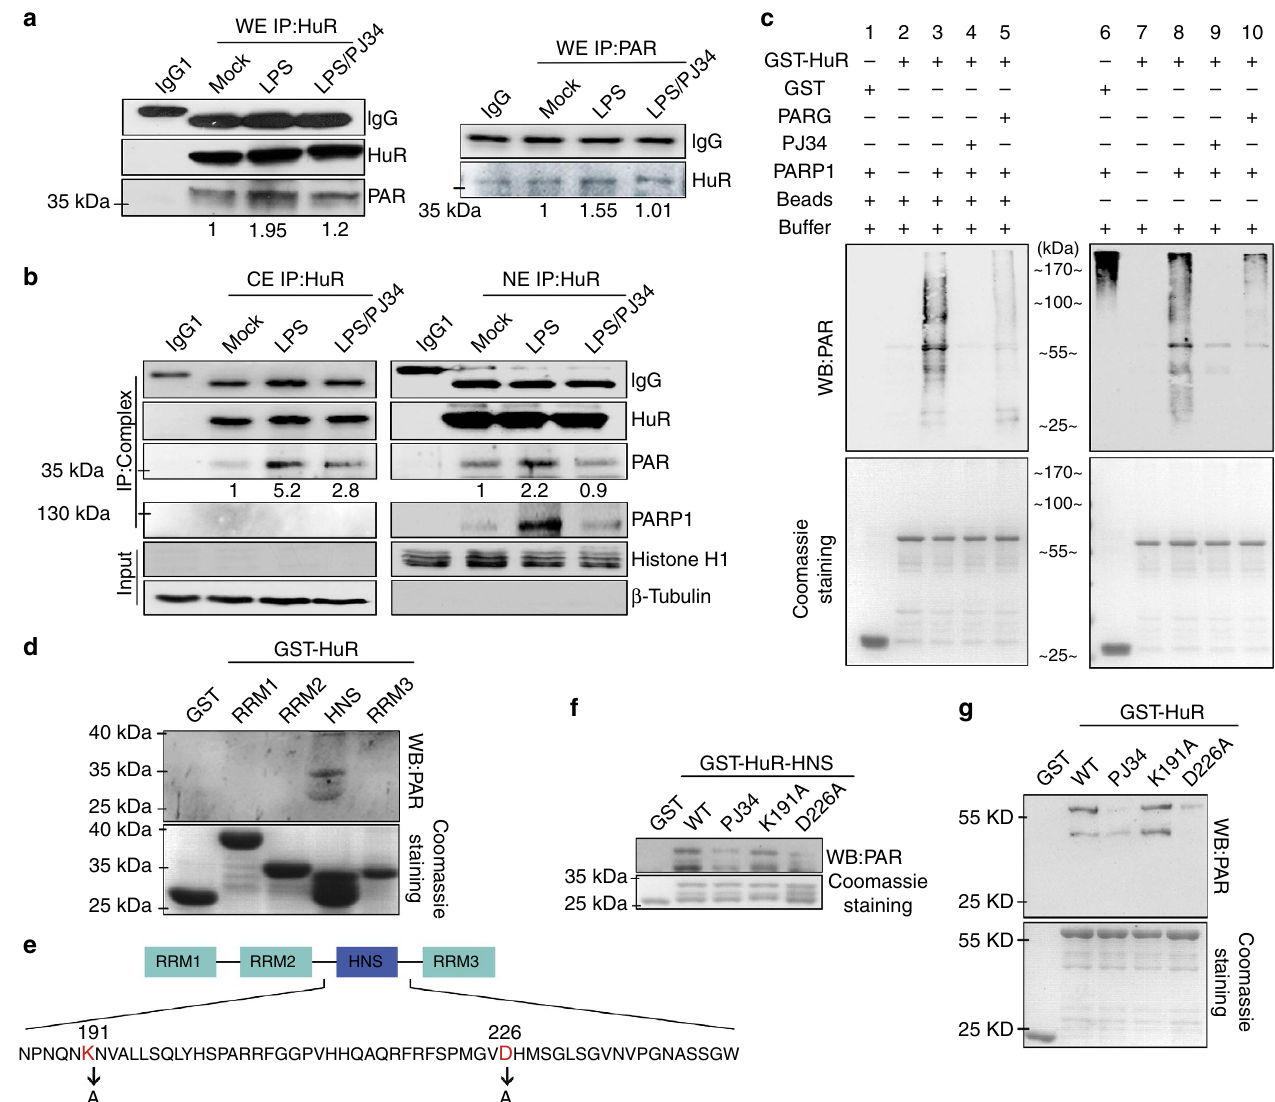
Figure 3 | PARP1 PARylates HuR primarily at aspartic acid 226 upon LPS stimulation. ( a ) LPS exposure increases the PARylation level of HuR. RAW 264.7 cells were mock-treated or LPS-exposed ( ± PJ34) for 5h. Immuno-precipitates were prepared using antibodies recognizing HuR (left) or PAR (right). The PARylation of HuR was detected using an antibody against PAR (left) or HuR (right). ( b ) LPS induces the PARylation of HuR in nuclear and cytoplasmic compartments. RAW 264.7 cells were treated differently as described in the legend to a . Cytosolic (CEs) and nuclear (NEs) extracts were prepared, and IP assays were performed using the HuR antibody. HuR’s binding with PARP1, and its PARylation, was assessed by immunoblotting. ( c ) HuR can be PARylated by PARP1 in vitro . Equal amounts of bead-coated (left) or soluble (right) GSTand GST-HuR were incubated with or without PARP1 in the presence or absence of PJ34 or PARG, and then subjected to immunoblotting to detect PARylation levels using Ab against PAR. ( d ) HNS is the major domain of HuR that is PARylated by PARP1. Equal amounts of GST-HuR domain mutants were incubated with recombinant protein PARP1 and then subjected to immunoblotting to detect PARylation levels. ( e ) The potential sites subjected to PARylation in the HNS domain of HuR. ( f , g ) D226 is the PARylation site of HuR. Equal amounts of wild-type (WT) GST-HuR-HNS, as well as K191 and D226 mutants ( f ), and full-length GST-HuR, as well as K191 and D226 mutants ( g ), were incubated with recombinant PARP1 protein and then subjected to immunoblotting to detect PARylation levels. Lower panels in c , d , f and g show the substrate amounts of recombinant GST and GST-fused proteins stained with Coomassie brilliant blue. RNA electrophoretic mobility shift assays (EMSA). GST-HuR or The direct incubation of eluted GST-HuR with probes showed the GST was purified and eluted, and then subjected to PARylation same patterns of the shifted bands (Fig. 6a, lanes 10–12) as that of or not, followed by incubation with biotin-labelled tandem samples subjected to PARylation (Fig. 6a, lanes 1–9); in parallel, ARE repeat-containing RNA oligos. GST-HuR elicited several as a vehicle control, PARP1 in PARylation buffer alone did not shifted bands, which might result from the various copies of GST- result in any shifted bands (Fig. 6a, lane 14). The addition of HuR harboured on the tandem ARE-containing probes (Fig. 6a, titrated cold probe resulted in a dose-dependent competition lanes 1–12), whereas GST failed to do so (Fig. 6a, (Fig. 6b), indicating the specificity of the binding of GST-HuR. lane 13). The incubation with PARP1 markedly enhanced the Furthermore, an antibody supershift assay was performed binding of GST-HuR with the probes (Fig. 6a, compare lanes 4–6 (Fig. 6c). Both HuR and GST antibodies led to super shifts from with lanes 1–3), which was inhibited by PJ34 (Fig. 6a, lanes 7–9). the protein–probe complexes (asterisk-labelled) while PARP1 NATURE COMMUNICATIONS|8:14632|DOI: